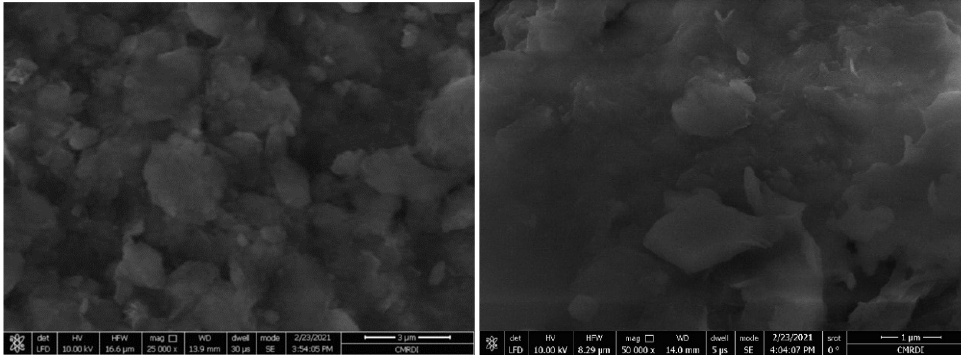
Figure 1. SEM micrographs of TiO 2.